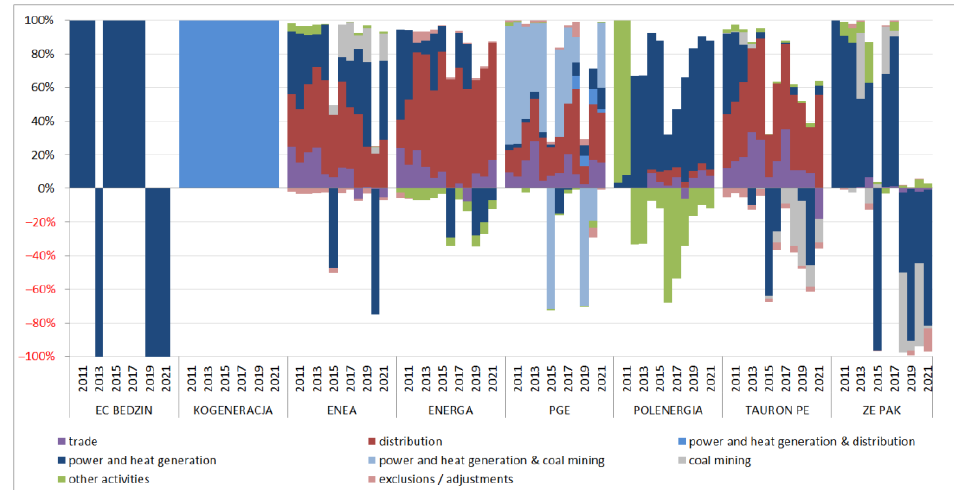
Figure 8. Structure of operating profit of the surveyed energy companies by business segment. Source: own elaboration.